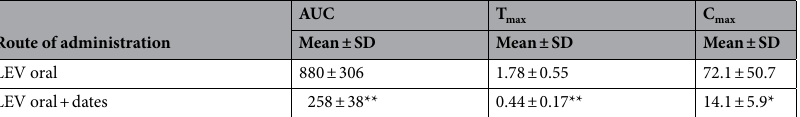
Table 1. The pharmacokinetic parameters of LEV after oral administration to rats with and without date molasses (mean SD). *p < 0.05 less than LEV oral. **p < 0.001 less than LEV oral.